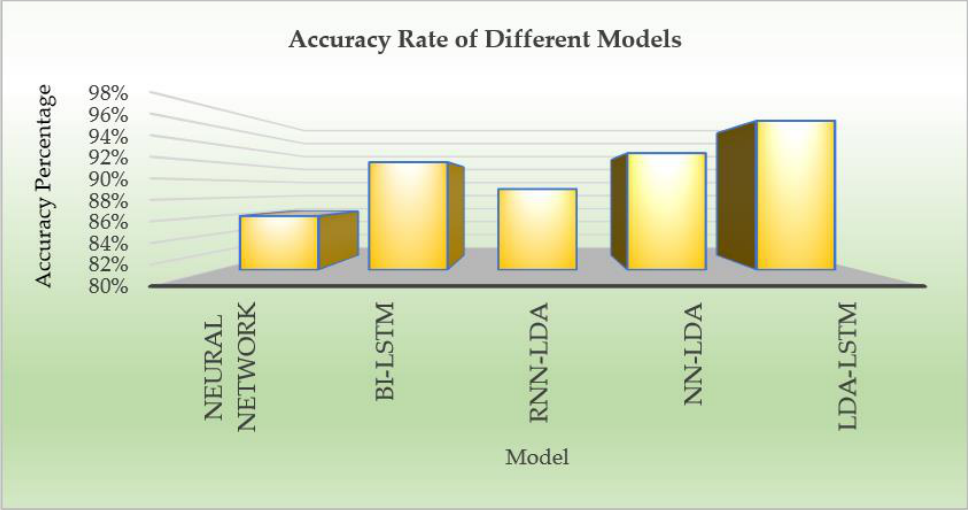
Figure 10. Accuracy Rate of Different Models.